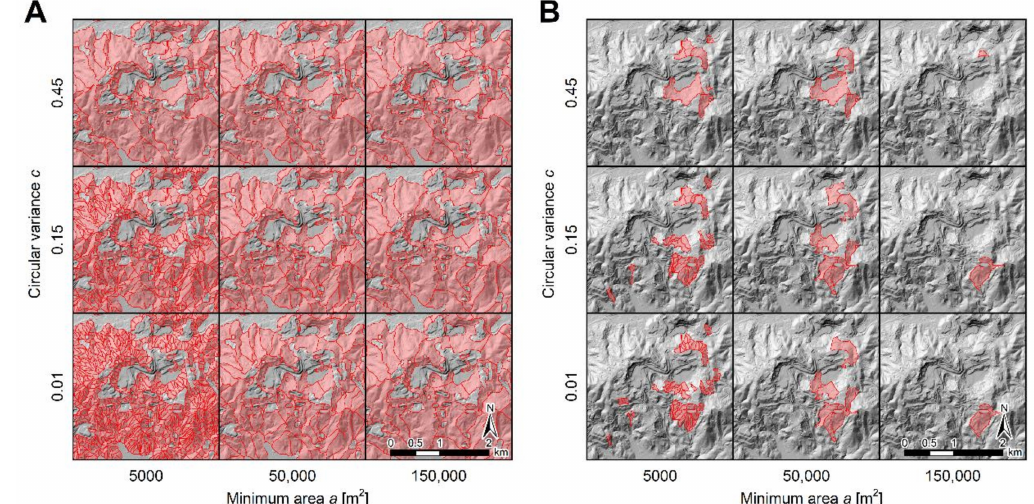
Figure 5. ( A ) Detail of the slope unit (SU) maps obtained with the software r.slopeunits [47] for several combinations of the input parameters a and c . ( B ) Detail of the active deformation slope unit (ADSU) maps obtained from the SU maps, as described in Section